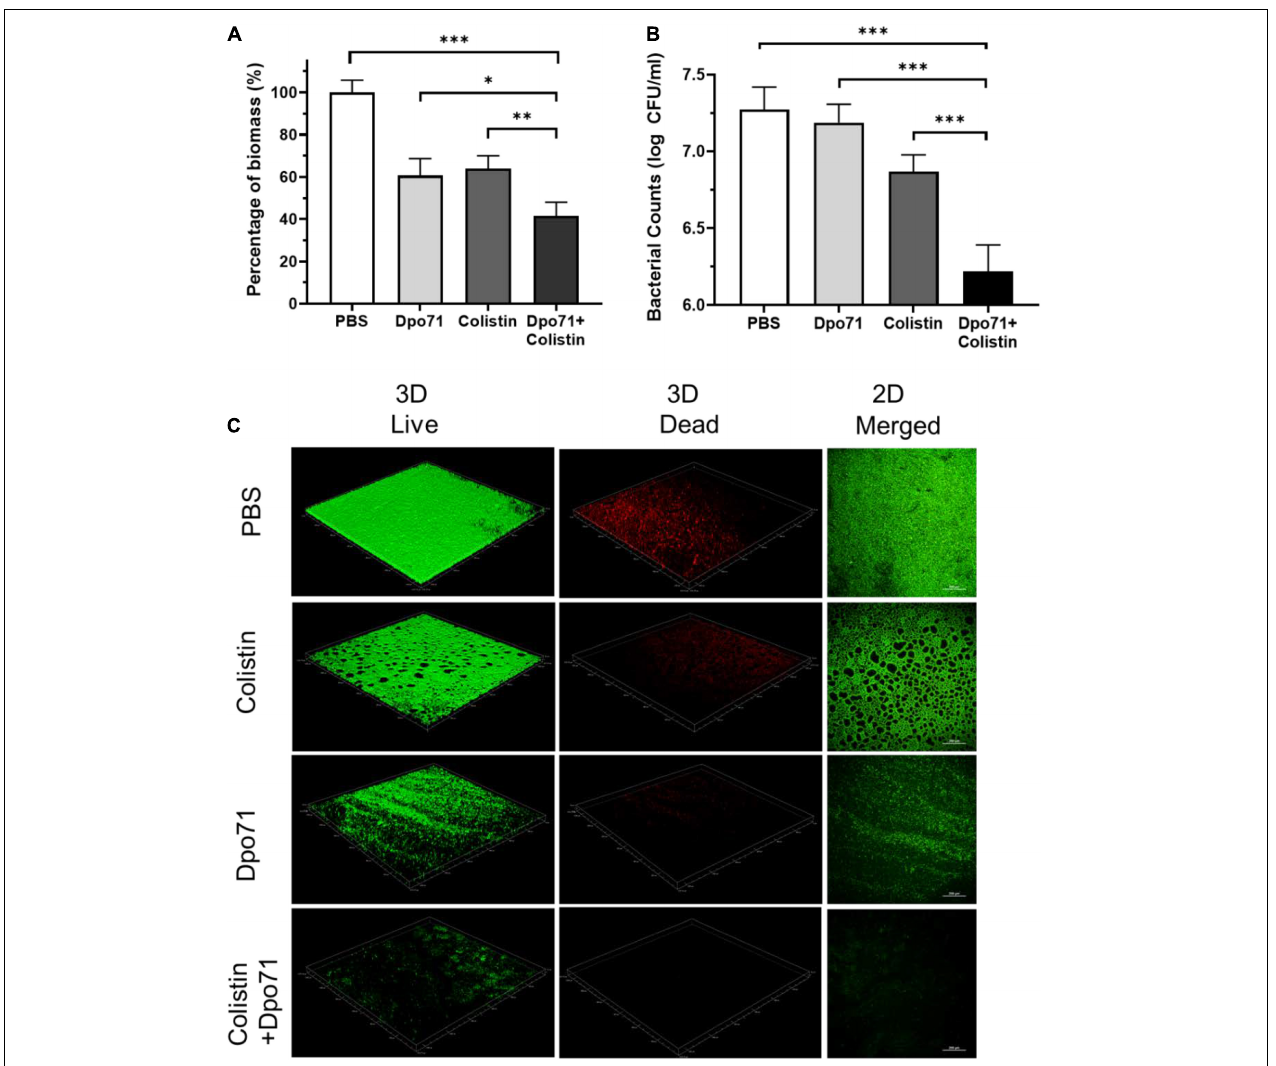
FIGURE 6 | Dpo71 and colistin disrupted the pre-formed biofilm. The residual biofilm was assessed by (A) crystal violet staining (the OD value of the PBS control was 2.12 ± 0.14) and (B) A. baumannii bacterial counts. Briefly A. baumannii s train was grown on 96-well plates for 24 h for biofilm formation first, and then the biofilm was treated with PBS buffer, Dpo71 (10 µ g/ml), colistin (4 µ g/ml) or Dpo71 + colistin for 24 h, followed with crystal violet staining and bacterial counting. Data are expressed as means ± SD ( n = 3). ∗ p < 0.05, ∗∗ p < 0.01, ∗∗∗ p < 0.001, Student’s t -test. (C) Representative confocal fluorescence microscopic images of live/dead stained A. baumannii biofilm (Scale bar, 200 µ m). Confocal dish was used instead of the 96-well plate